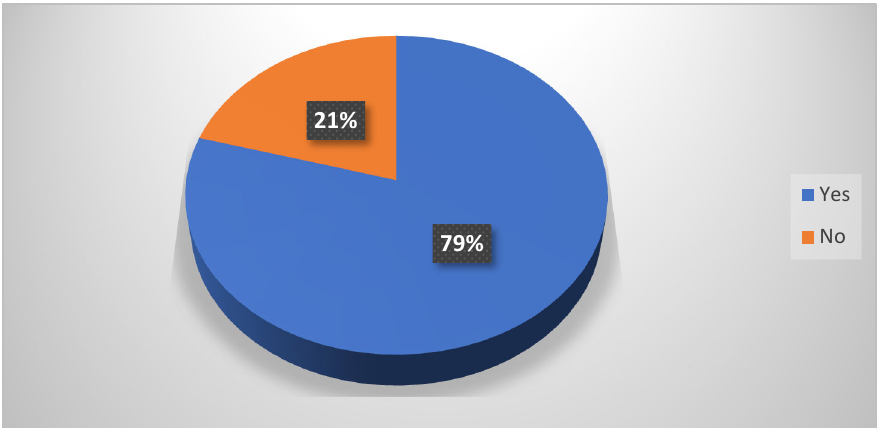
Figure 1. Utilization of Antenatal care services among women of reproductive age in South Africa.